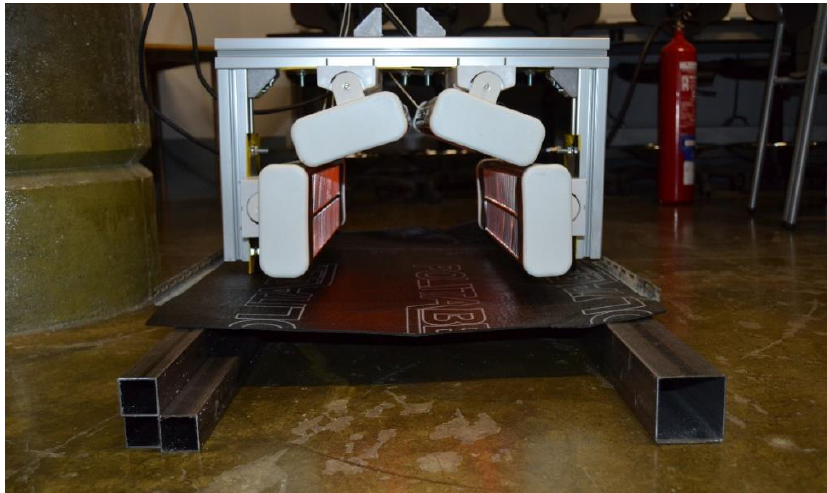
Figure 13. Infrared heaters pointing to a one-layer sample of an asphalt roofing roll.